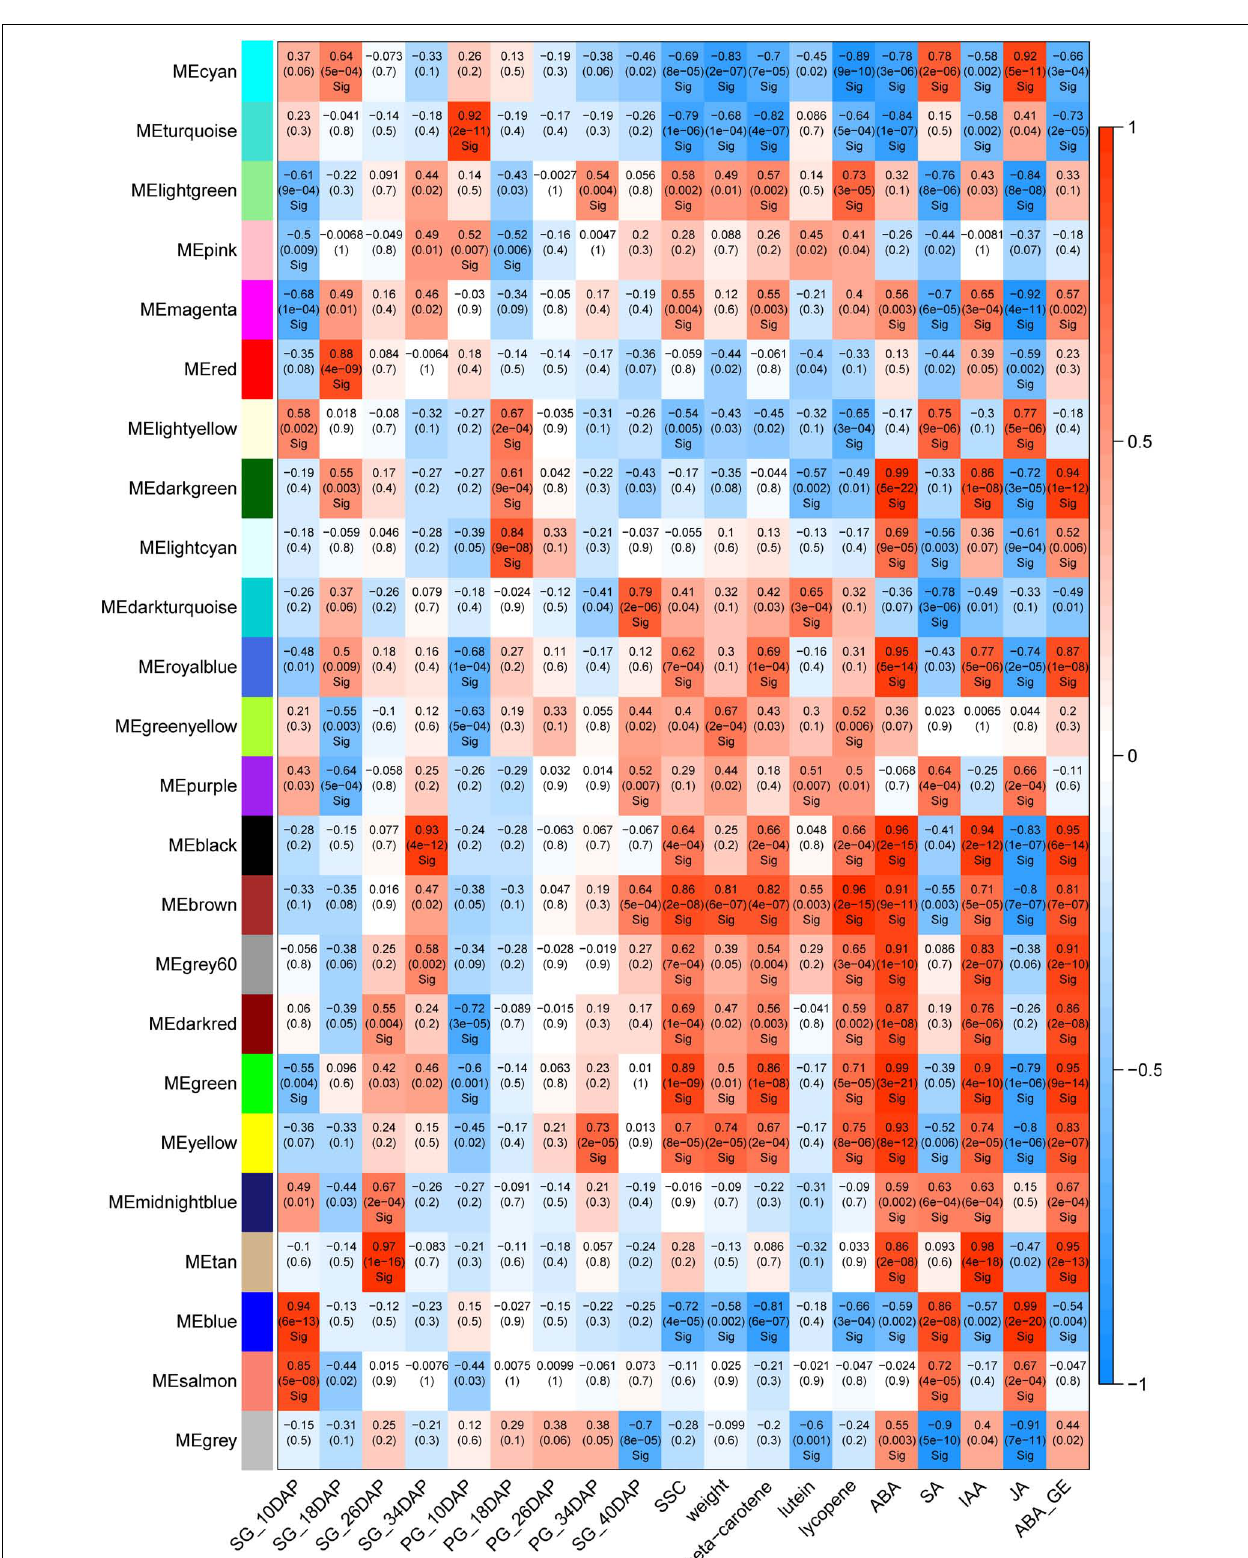
FIGURE 6 | Weighted gene co-expression network analysis (WGCNA) module analysis of the differentially expressed genes in self-grafted (SG) watermelon plant and pumpkin-grafted (PG) watermelon plant.